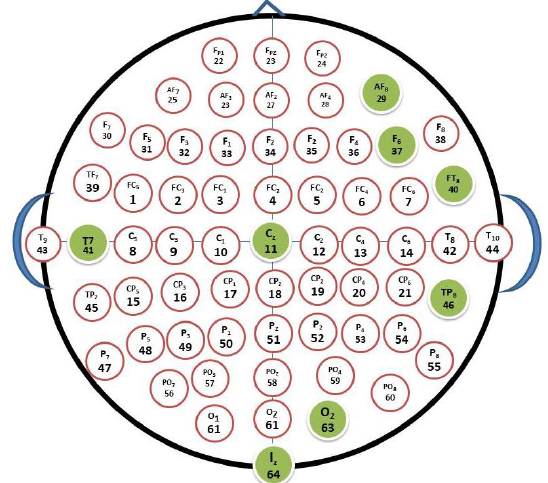
Figure 8. Highly ranked features of classification are extracted from the time – frequency analysis. Highlighted channel plots are engaged in identifying the complex emotions with 280 features in total.